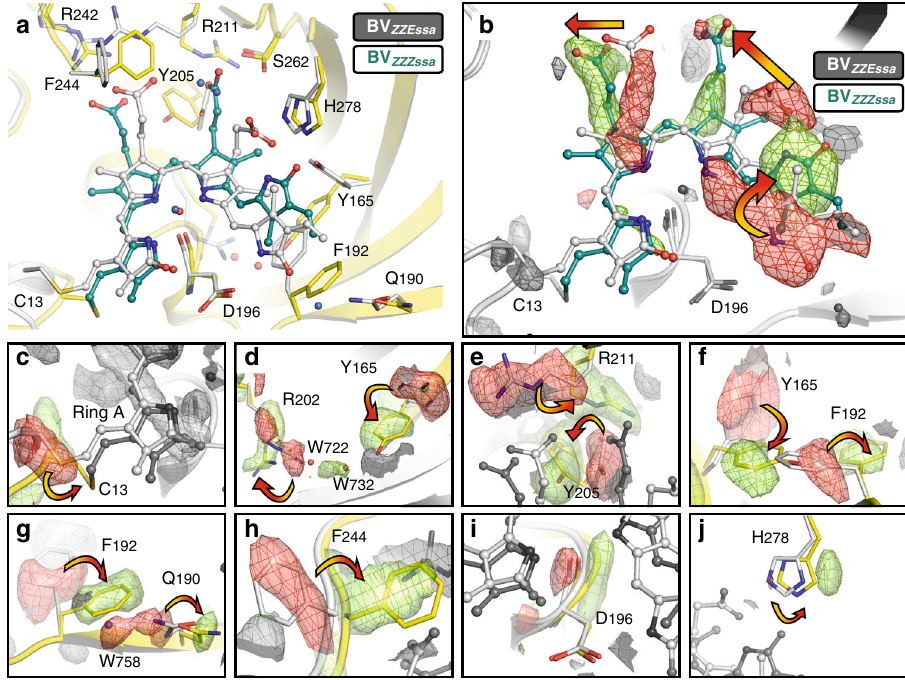
Fig. 6 Superposition of Agp2-PAiRFP2 Meta-F and Pfr state. a Cartoon representation of the structures of the chromophore pocket. BV and amino acids of the chromophore pocket are shown as ball/sticks and sticks, respectively. In the Pfr structure, BV and amino acid side chains are coloured light grey and water molecules are depicted as blue spheres. In the Meta-F sub-state structure (Mol A), BV is coloured teal, protein in yellow and water molecules are depicted as red spheres. b The Fo Meta-F − Fo Pfr electron density map of BV shows structural changes in the chromophore associated with the Pfr → Meta-F transition. Expanded views of sections of b are shown in c – j . Positive Fo Meta-F − Fo Pfr electron density map is coloured green, whereas negative Δ Fo electron density is coloured in red. For the sake of clarity, Δ Fo electron density and amino acids that do not belong to the highlighted amino acid in the corresponding fi gure were coloured light and dark grey. In c – j , Δ Fo electron density is contoured at 3.0 σ and in b at 4.0